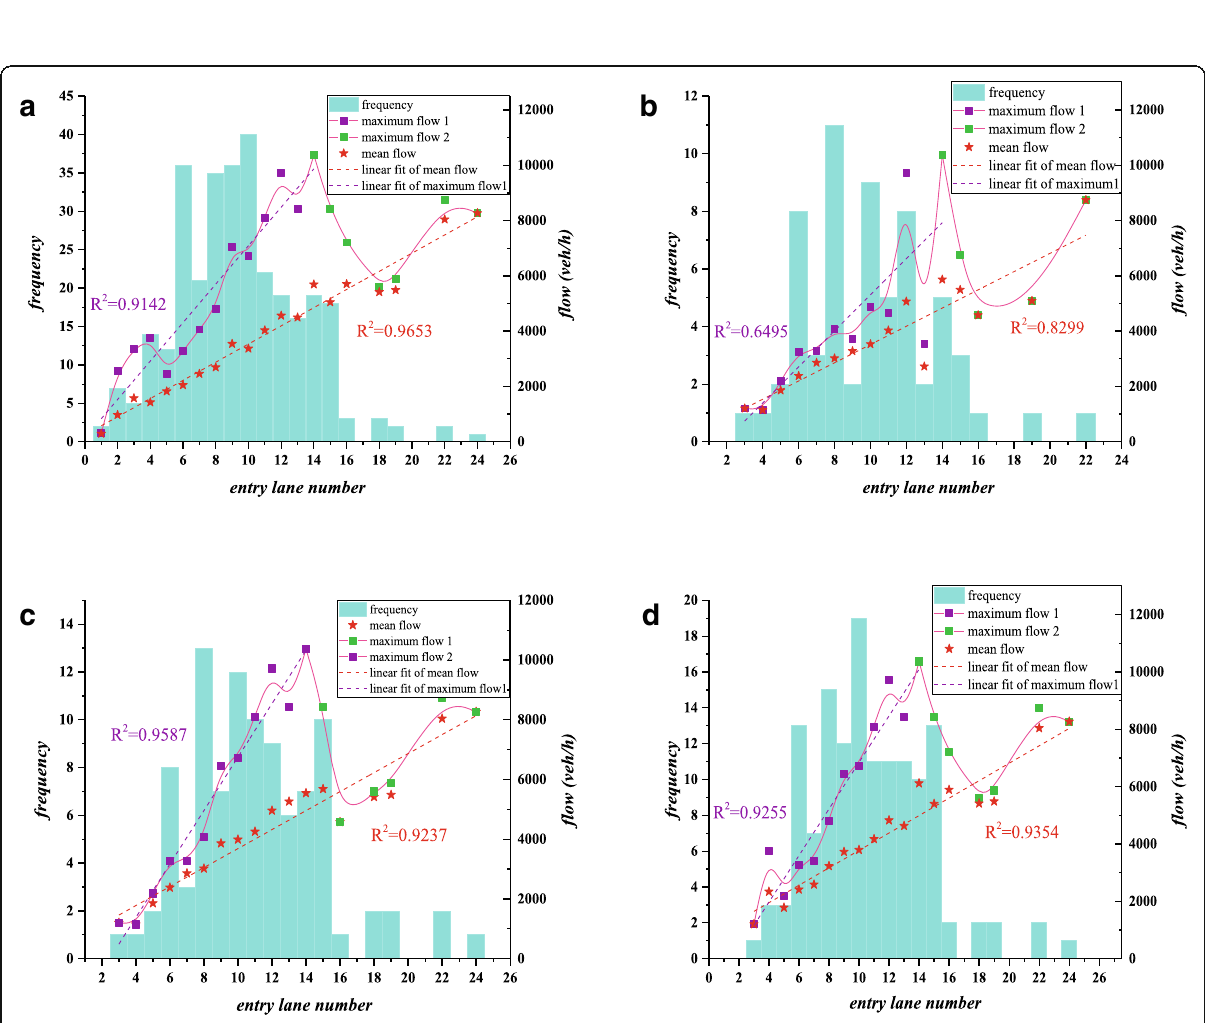
Fig. 10 Correlation between entry lane number and peak hour flow of intersections: ( a ) the whole M 1 ; ( b ) intersection set M 2 ; ( c ) intersection set M 3 of ξ j = 0.9; ( d ) intersection set M 4 of ξ j = 0.8